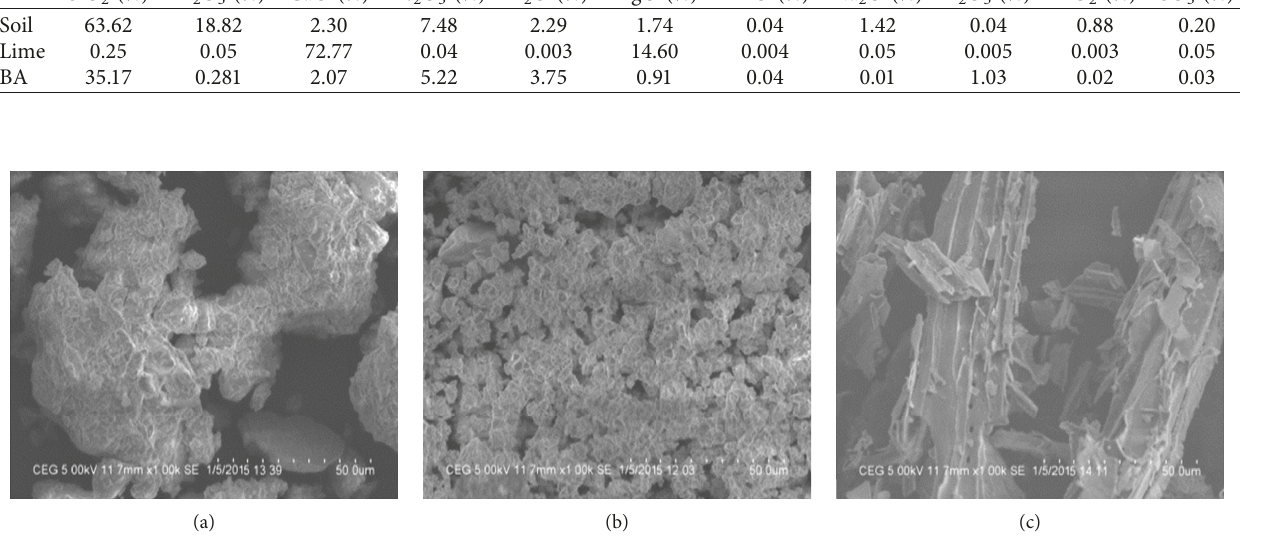
Figure 2: SEM micrograph of the materials adopted in the study: (a) soil, (b) lime, and (c) BA.